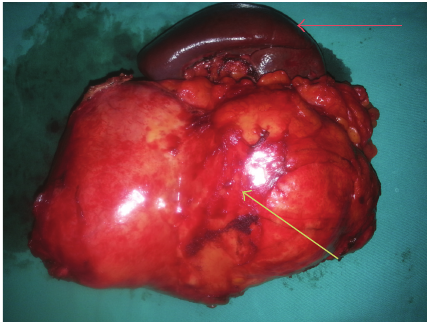
Figure 3: Total cystectomy and splenectomy specimen (red arrow shows the spleen and yellow arrow shows the cystic